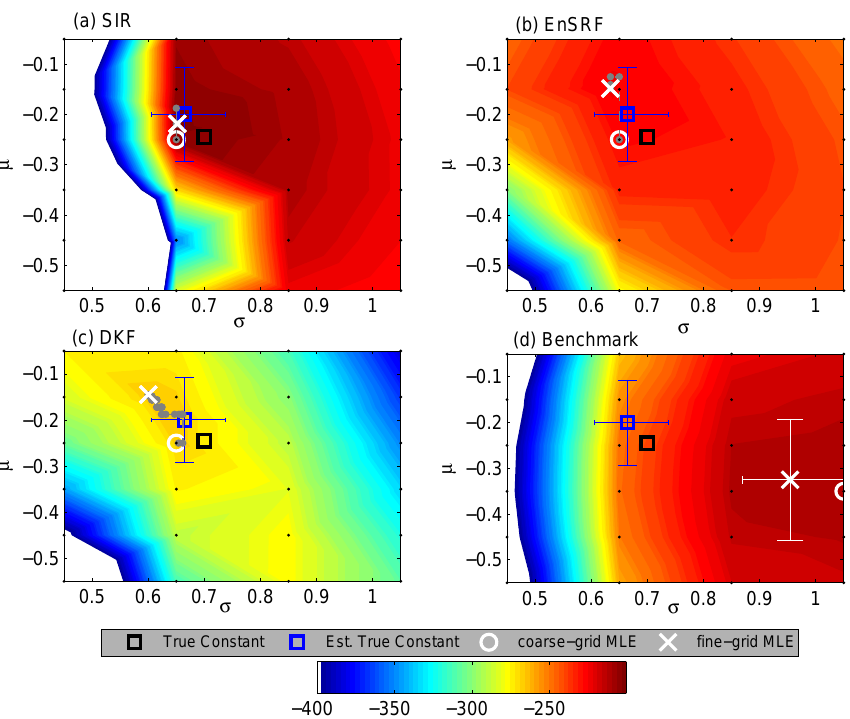
Fig. 8. Complete marginal log-likelihood contour levels of a single 200-event point process simulation as a function of the parameters { µ,σ } , approximated by (a) the SIR particle filter, (b) the EnSRF, (c) the DKF and (d) the benchmark. We also show the “true” constants (black square), the maximum likelihood estimates (and 95% confidence bounds) using the (unobservable) “true” occurrence times (blue square). The grid of the coarse-grid search is indicated by black dots. The path of the pattern search optimization is shown in grey leading to the final maximum likelihood estimate.